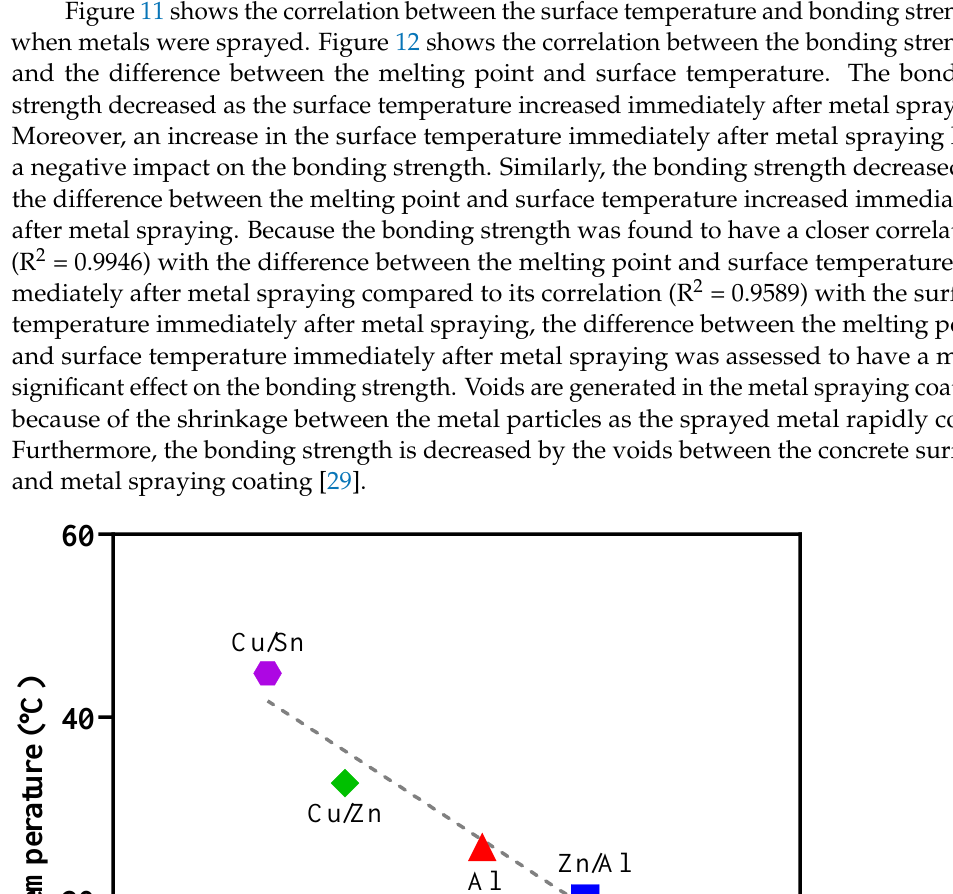
Figure 12. Relationship betwee n the bonding strength and Δtemperature.